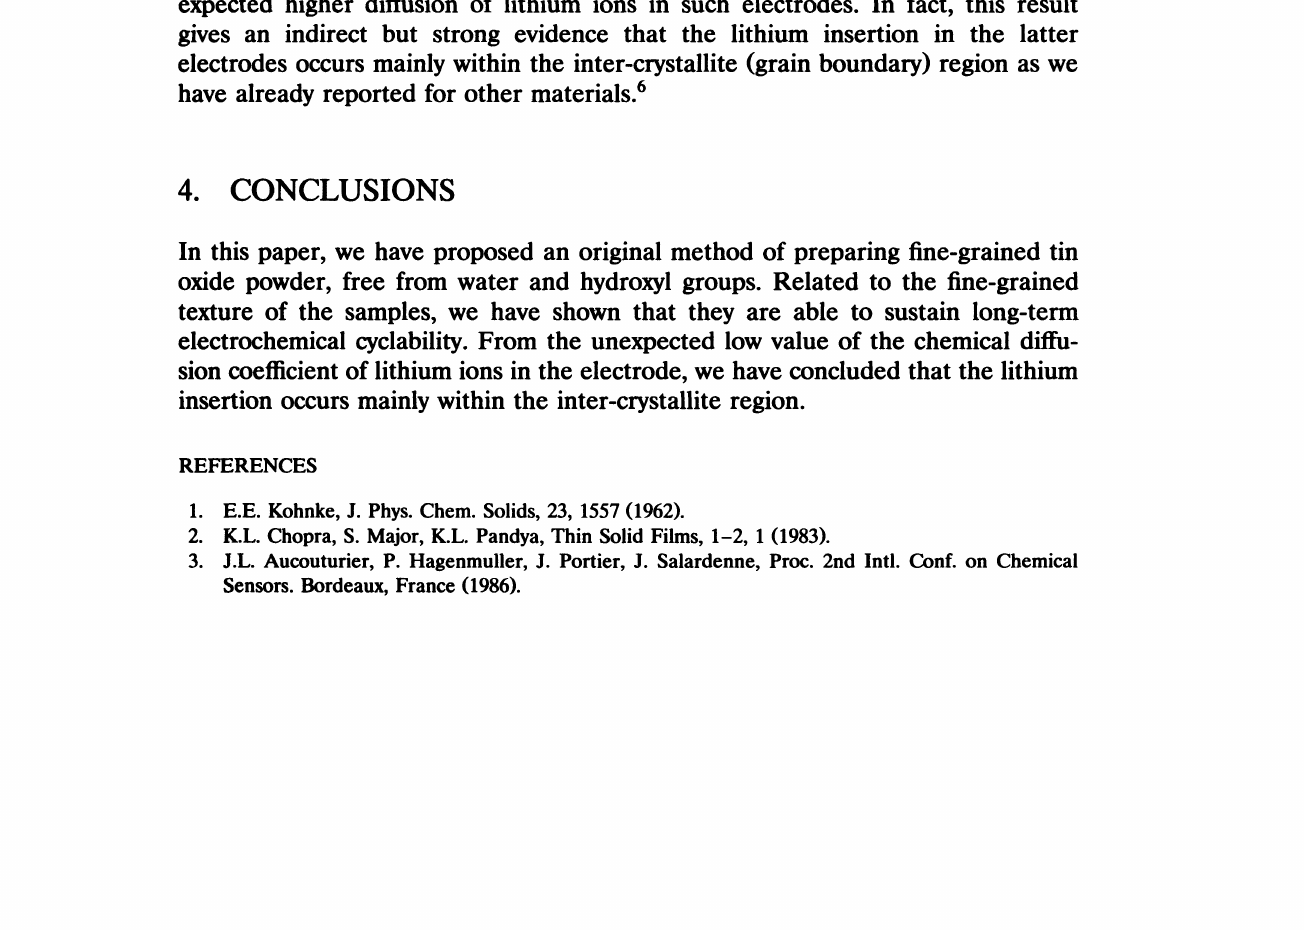
FIGURE 7 Broadening of the X-ray diffraction peaks upon Li + insertion in the LixSnO (a) commercial powder; (b) fine-grained